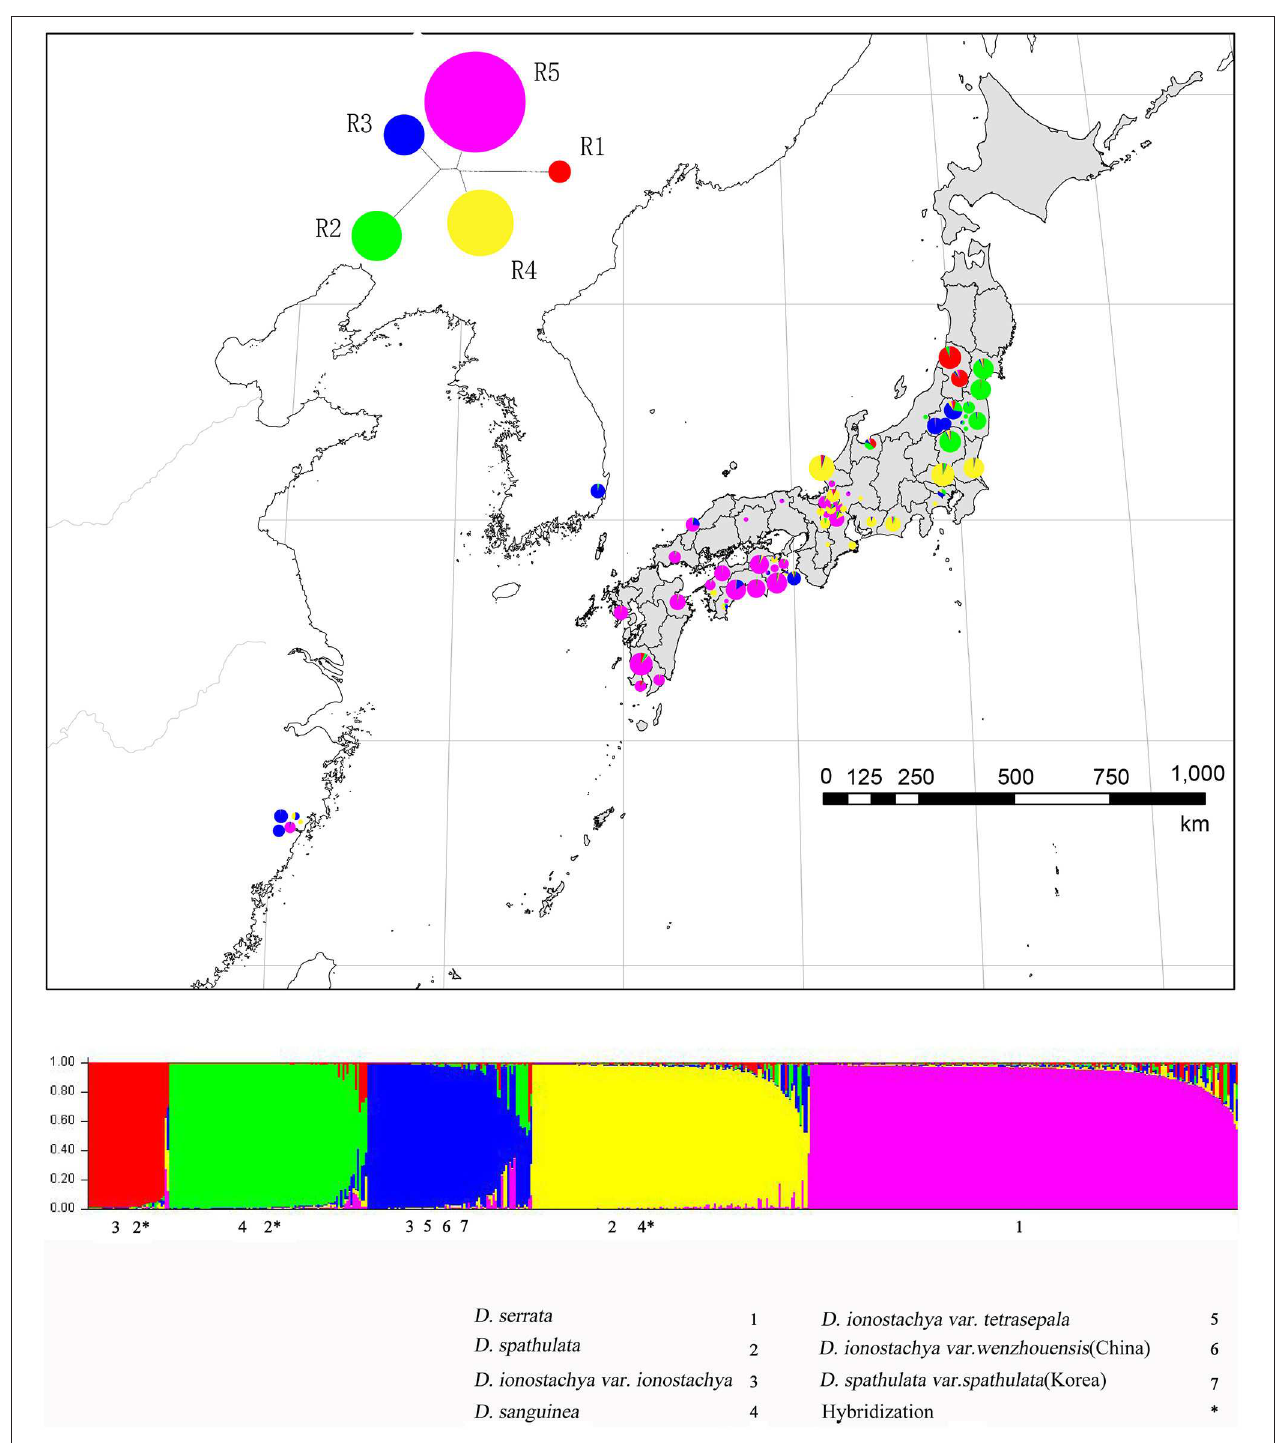
FIGURE 3 | Results of STRUCTURE analysis for all individuals of Diabelia studied based on nSSR data. Assignment of individuals to genetic clusters at K = 5.